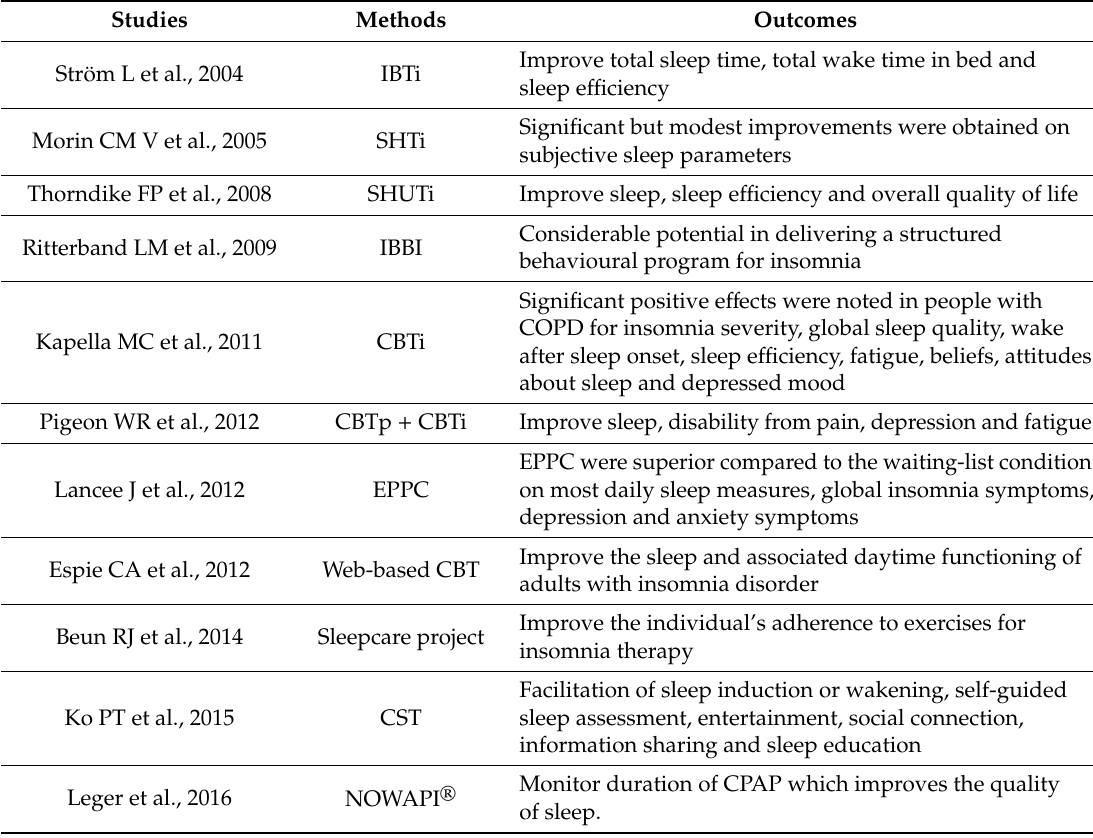
Table 1. Current use of information and communication technologies (ICT) for insomnia in elderly